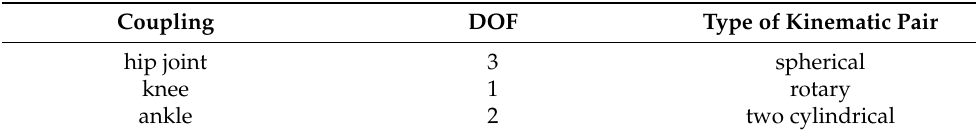
Table 2. Analysis of joints in the lower part of the human